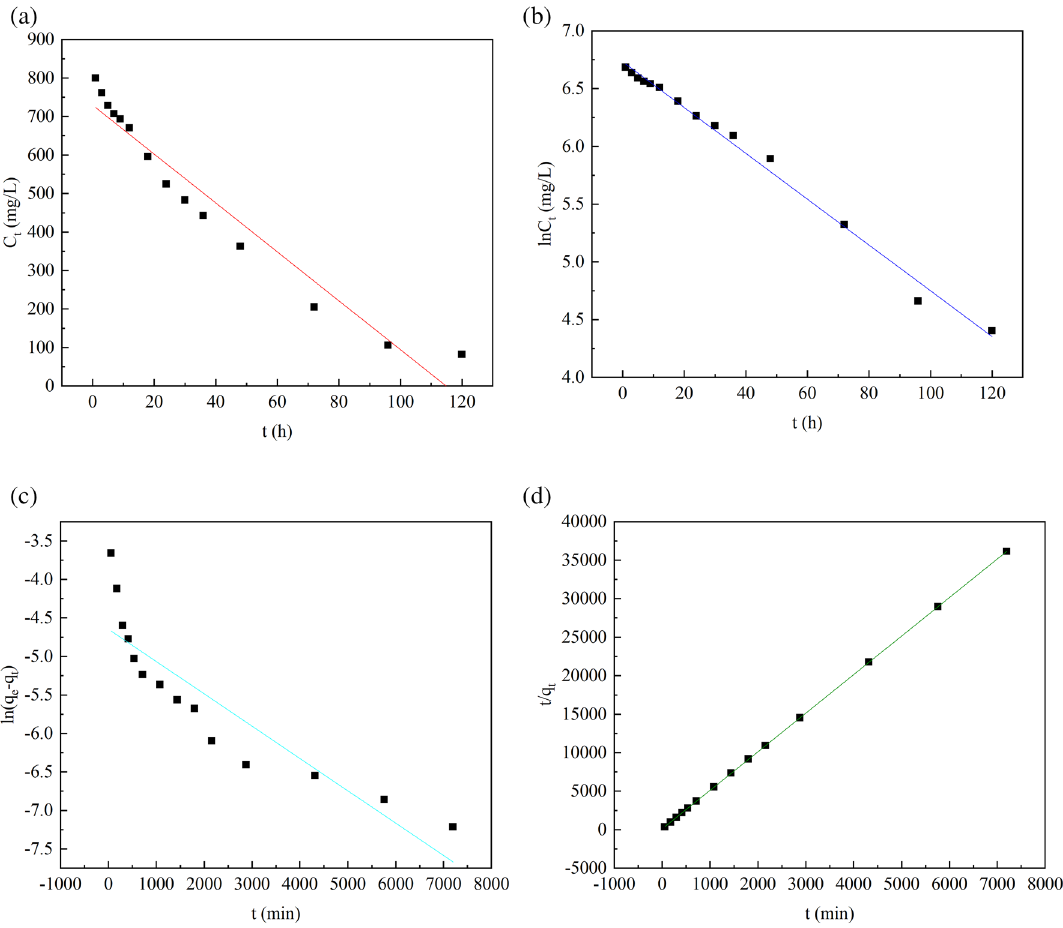
Figure 7. Kinetic fitting. ( a ) Zero-order kinetics of reduction of SO 4 2− . ( b ) First-order kinetics of SO 4 2− . ( c )